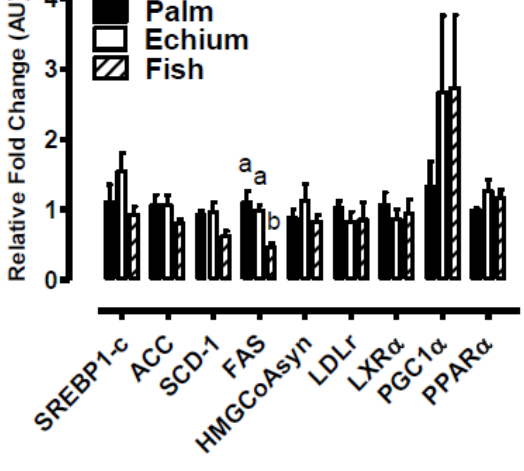
Figure 4. Hepatic gene expression. Mice were fed experimental diets containing PO, EO or FO for 16 weeks before livers were harvested for measurement of gene expression by quantitative real-time PCR. Liver RNA was isolated using TRIzol from individual mice and quantified for the indicated genes. Values represent mean ± S.E.M.; n = 3–5 per diet group. Values with different letters are significantly different from one another ( p <